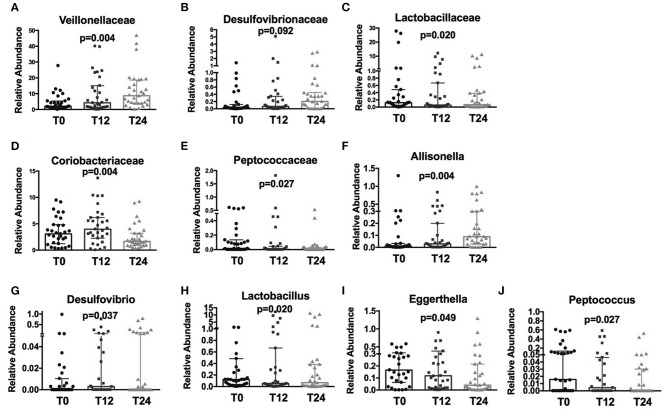
Fecal relative abundance of bacteria Family and Genus taxa following cART introduction. The presented data refer to taxa at family and genus levels in HIV -infected patients before (T0) and after cART (T12, T24). (A) Significant increase in Veillonellaceae family (p = 0.004). (B) Increasing trend in Desulfovibrionaceae (p = 0.92); (C–E) significant decrease, respectively, in Lactobacillaceae, Coriobacteriaceae, and Peptococcaceae families (p = 0.020, p = 0.004, p = 0.027, respectively). (F,G) Significant increase in Allisonella and Desulfovibrio genera (p = 0.004, p = 0.037, respectively). (H–J) Significant decrease, respectively, in Lactobacillus, Eggerthella, and Peptococcus genera (p = 0.020, p = 0.049, p = 0.027, respectively). Data analyzed by Anova, p-values are not adjusted for multiple comparisons.